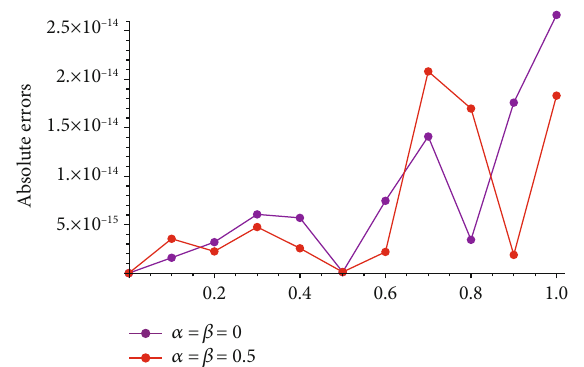
Figure 15: Absolute errors of u 1 obtained by the present method with α = β = 1/2 (red), α = β = 0 (purple) for Example 2.